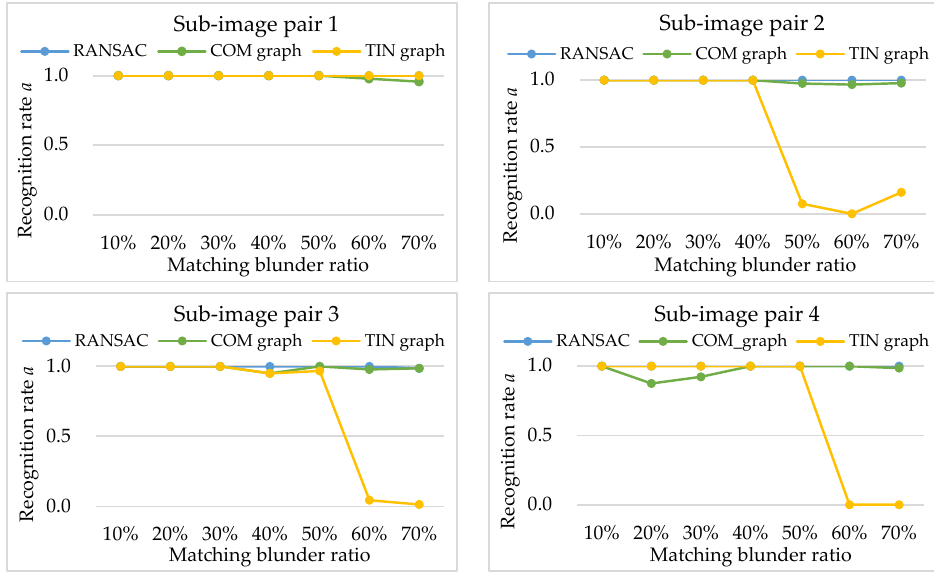
Figure 6. Experimental results of recognition rate a .